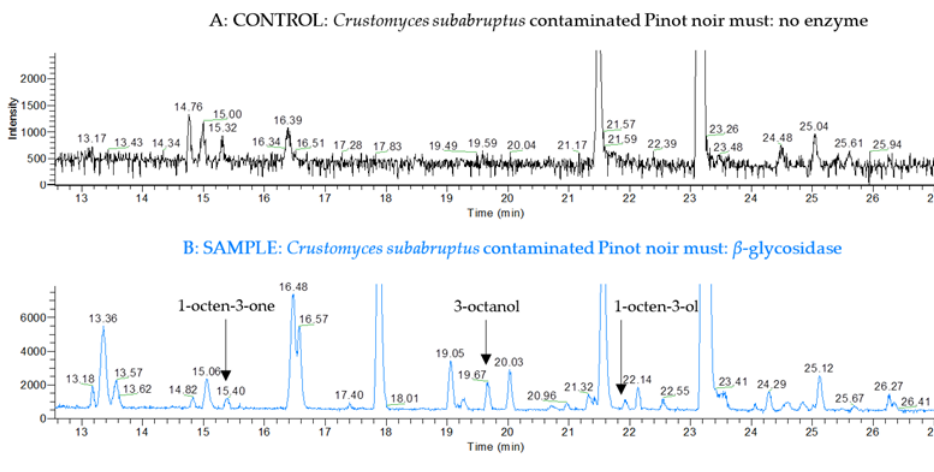
Figure 2. Chromatogram of compounds released from the must of the contaminated Pinot noir model with and without enzyme addition. ( A ) CONTROL: Crustomyces subabruptus contaminated Pinot noir must: no enzyme. ( B ) SAMPLE: Crustomyces subabruptus contaminated Pinot noir must: β -glycosida.